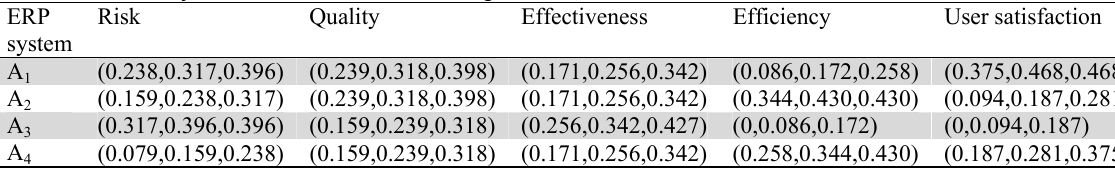
Normalized fuzzy decision matrix for example 1